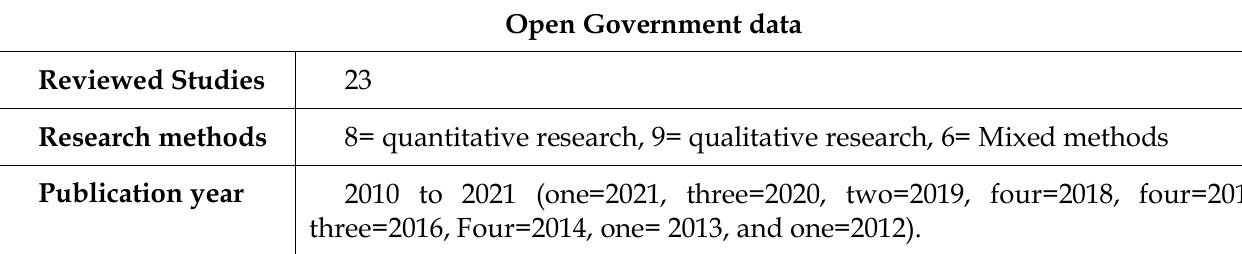
Table 1: Selected Studies on Open Government Data